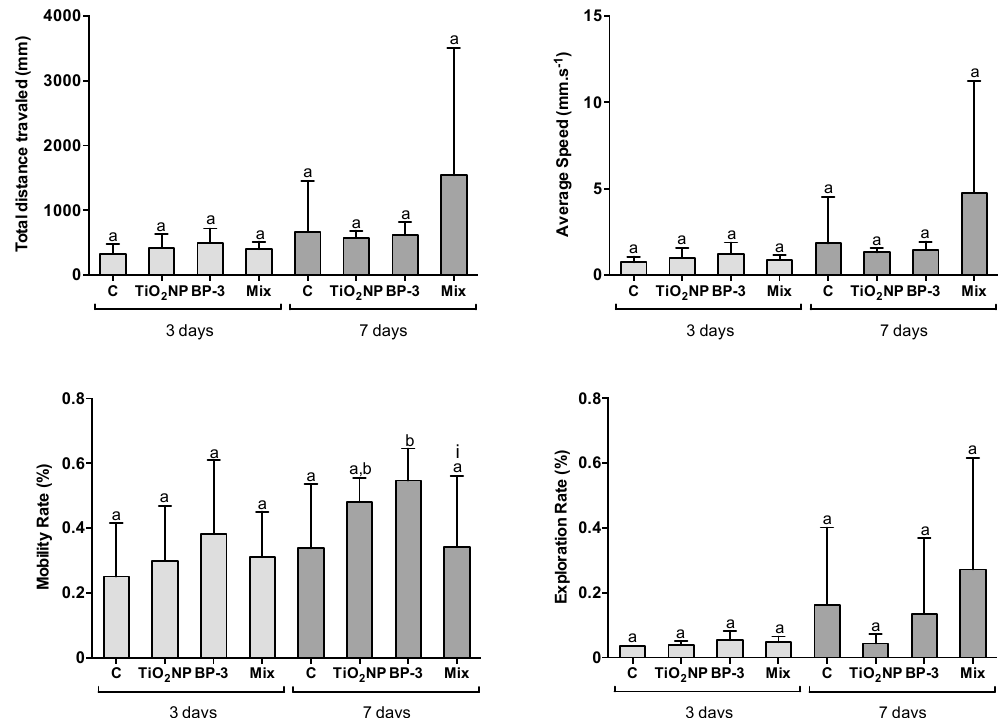
Figure 8. Behavioural analysis of S. maximus , 3 and 7 days after intraperitoneal injection of titanium dioxide nanoparticles (TiO 2 NPs; 3.0 µ g TiO 2 NP per g fish weight), oxybenzone (BP-3; 3.0 µ g BP-3 per g fish weight) or their mixture (Mix), as well as the respective control group (C). Results translate behaviour endpoints determined in the white compartment of the dark-light device (adaptation of scototaxis test). Different lower-case letters denote significant differences ( p < 0.05). Significant interaction between TiO 2 NPs and BP-3 is depicted by (i) ( p < 0.05). Columns correspond to mean and error bars represent the standard deviation.